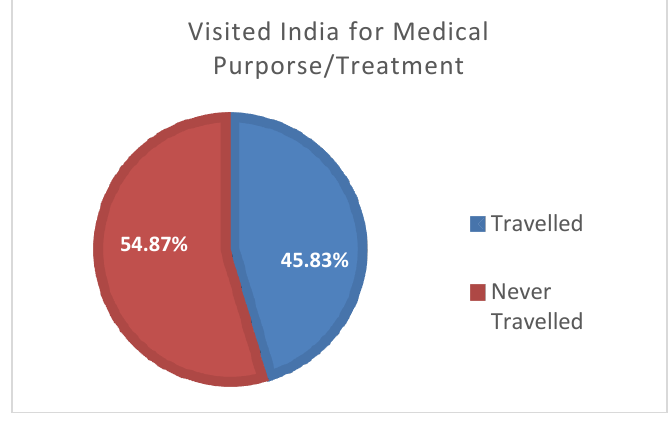
Figure 7: Most Preferred Indian Cities for Afghans (Source: Authors‟ depiction )